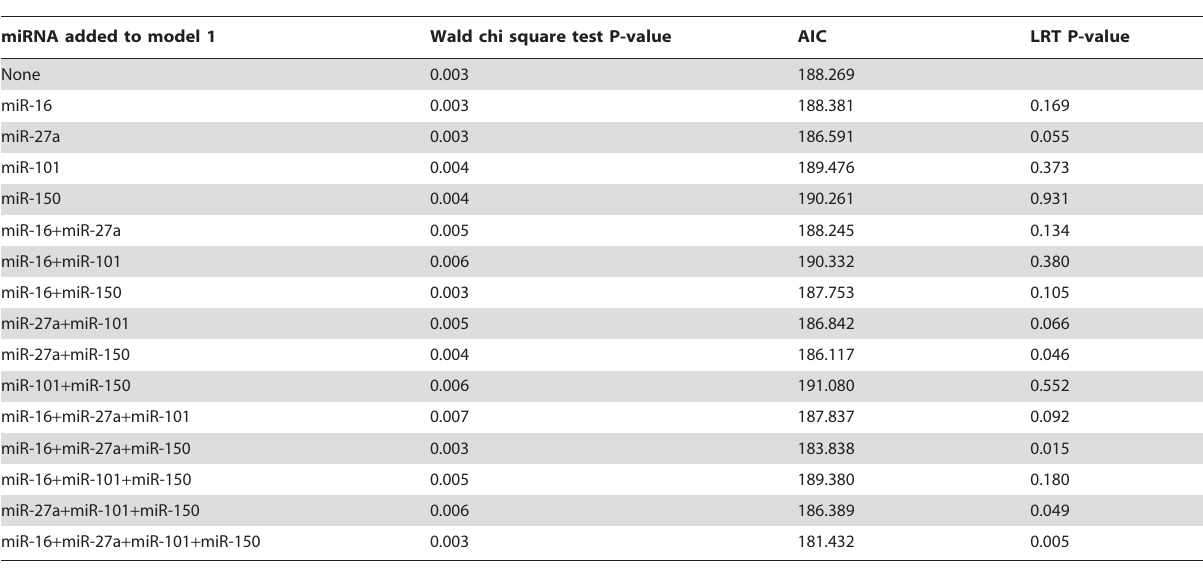
Table 3. Added value of combinations of miRNAs (logistic regression).